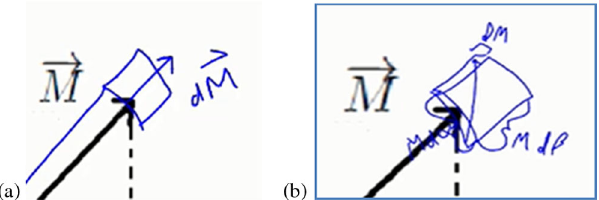
FIG. 4. Physical construction of a differential volume element by Rachel and Silas. (a) Beginning of volume construction using the single length component. (b) Final differential volume, where location of dM has changed. Students do not connect the sides of the volume to length